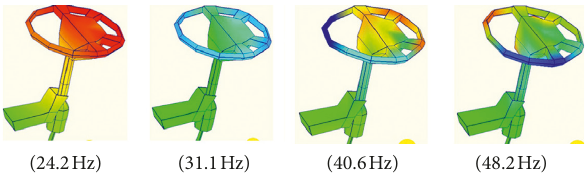
Figure 18: Modal modes and frequencies of the steering system under hammer impact.